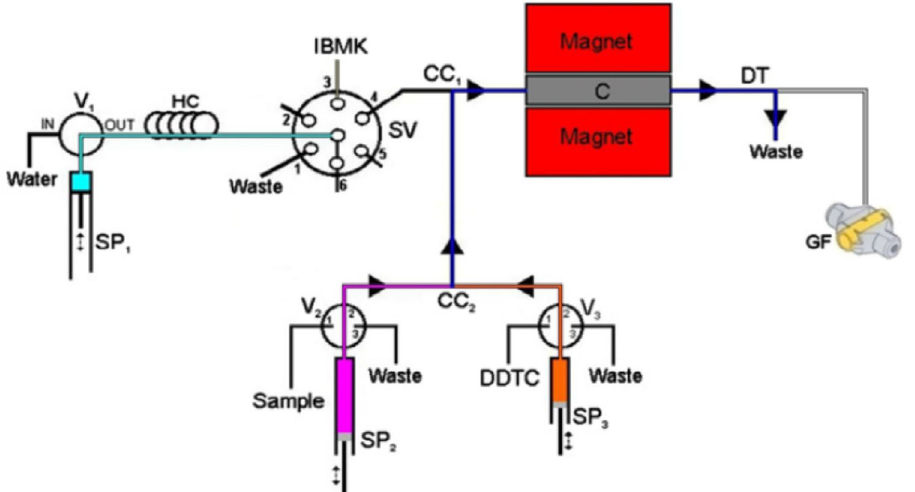
Fig. 12. Schematic diagram of the SI-MSPE-ETAAS system for cadmium determination. SV, selection valve; SP 1 , SP 2 , SP 3 , syringe pumps; HC, holding coil; CC 1 , CC 2 , confluence connectors; DT, delivery tube; C, microcolumn; GF, graphite furnace of ETAAS; IBMK, isobutylmethylketone; DDTC, diethyldithiocarbamate [113].